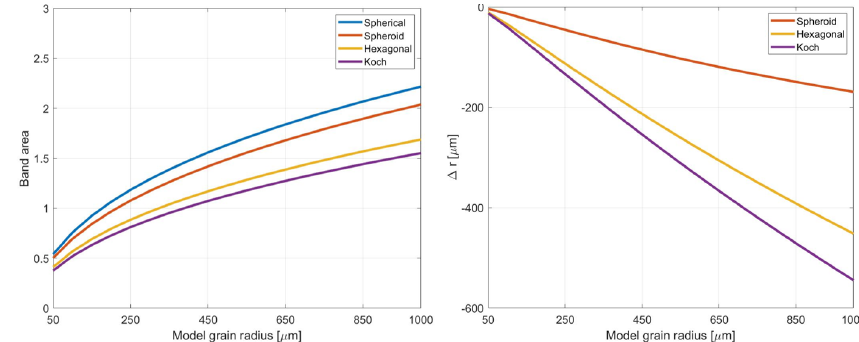
Figure 5. Same as Fig. 4 but for changes in ice particle shape. Estimated biases are relative to spherical ice